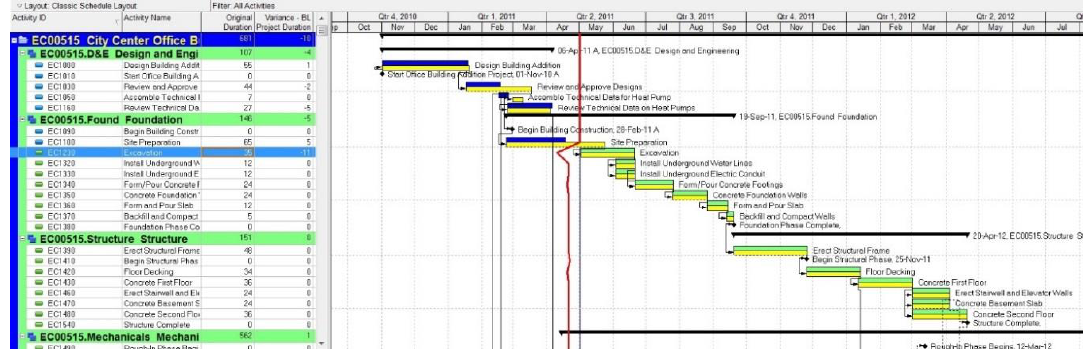
Figure 9. Baseline in blue bar and actual timeline in yellow bar.